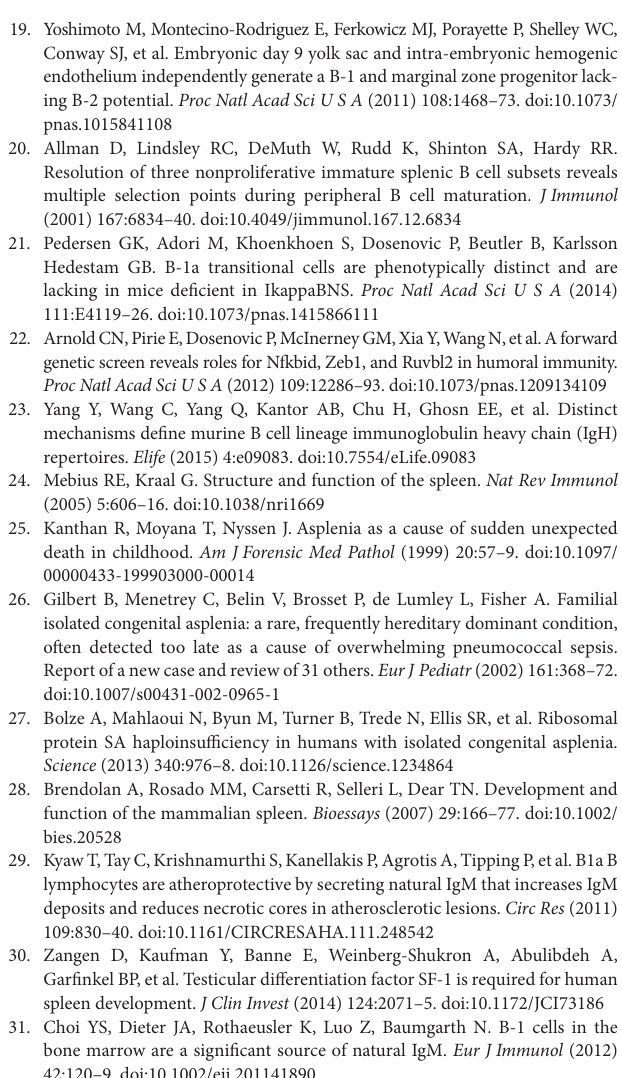
FigUre s3 | B-1a cell development from fetal liver cells transferred into already splenectomized hosts. Wild-type (wt) FL cells were isolated from 11 days old embryos (E11) and transferred to adult RAG1 − / − mice that had undergone splenectomy or sham surgery 30 days earlier. At 6 weeks later the mice were sacrificed and analyzed for B-1a cells. Donor-derived B-1a cells were identified as IgM + Cd19hiB220loCD43 + CD5 + . No IgM positive cells were observed in the peritoneum of RAG1 − / − mice that had not received wt cells (not shown). (a) Schematic of the study. (B) Representative plots of peritoneal cavity B cells after transfer of E11 cells into splenectomized versus sham-operated recipients.